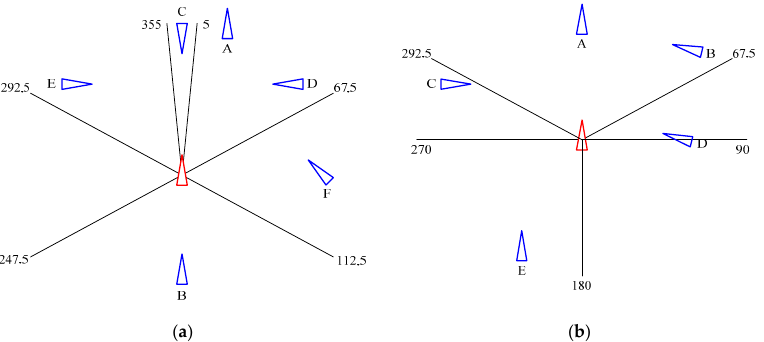
is action value, and the range of action values is ( − 1, 0, 1). A value of − 1 indicates that OS should change course to the port side, 0 means that either a change to the port side or starboard is possible, and 1 means that OS should